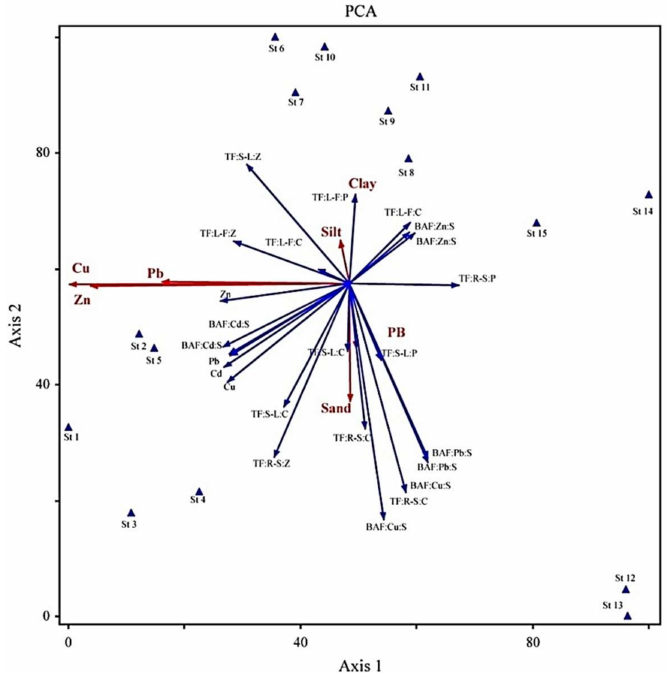
Figure 3. PCA-biplot depicting relationships between metal bio-concentration, accumulation and translocation factors of metals with soil spatial and textural properties at different abandoned habitats in Khyber Pakhtunkhwa, Pakistan. Note: St (Stand), St.1 (KTS (Kanju Town Junction)), St.2 (GTM (GT Road Mingora)), St.3 (SKR (Skhakot Road)), St. 4 (SMR (Shamozu Road)), St. 5 (PC (Peshawar)), St. 6 (HIZ (Hayatabad Industrial Zone)), St. 7 (MKI (Mardan Kid Industry)), St. 8 (BKP (Barikot Crush Plant)), St. 9 (CUA (Charsadda Urban)), St. 10 (MSM (Mardan Shiekh Malton)), St. 11 (TFN (Tarnab Form)), St. 12 (TBM (Takht Bhai)), St. 13 (GCD (Gulabad College Degree)), St. 14 (AMS (Amankot)), St. 15 (CBS (Charbagh